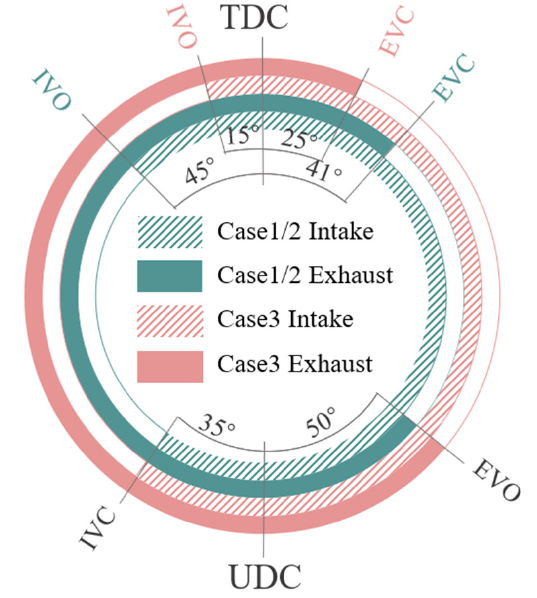
Figure 2. Intake/Exhaust valve timing of the three cases. Table 2. Parameter details of the three cases.